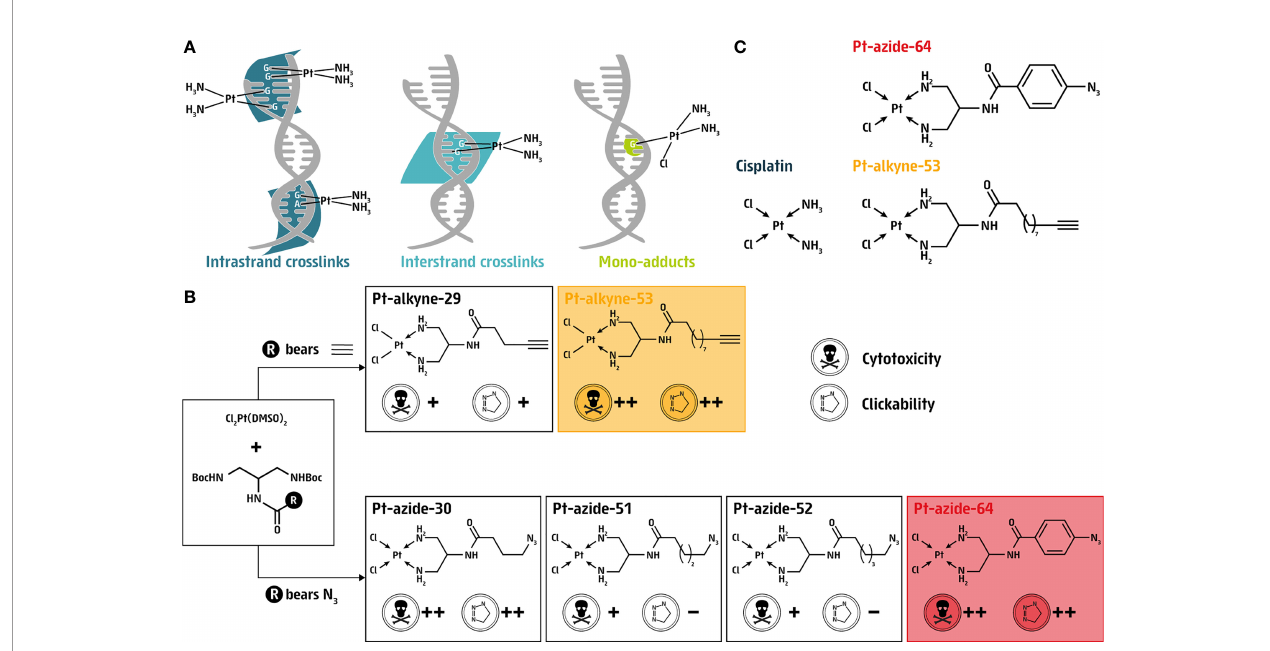
FIGURE 1 | Synthesis of clickable cisplatin derivatives. (A) Schematic representation of intrastrand and interstrand crosslinks as well as mono-adducts induced by cisplatin. (B) Selection criteria for the generation of clickable cisplatin derivatives generated in this study; Pt-alkyne or Pt-azide compounds. (C) Chemical structures of cisplatin along with the two prioritized clickable cisplatin derivatives Pt-alkyne-53 and